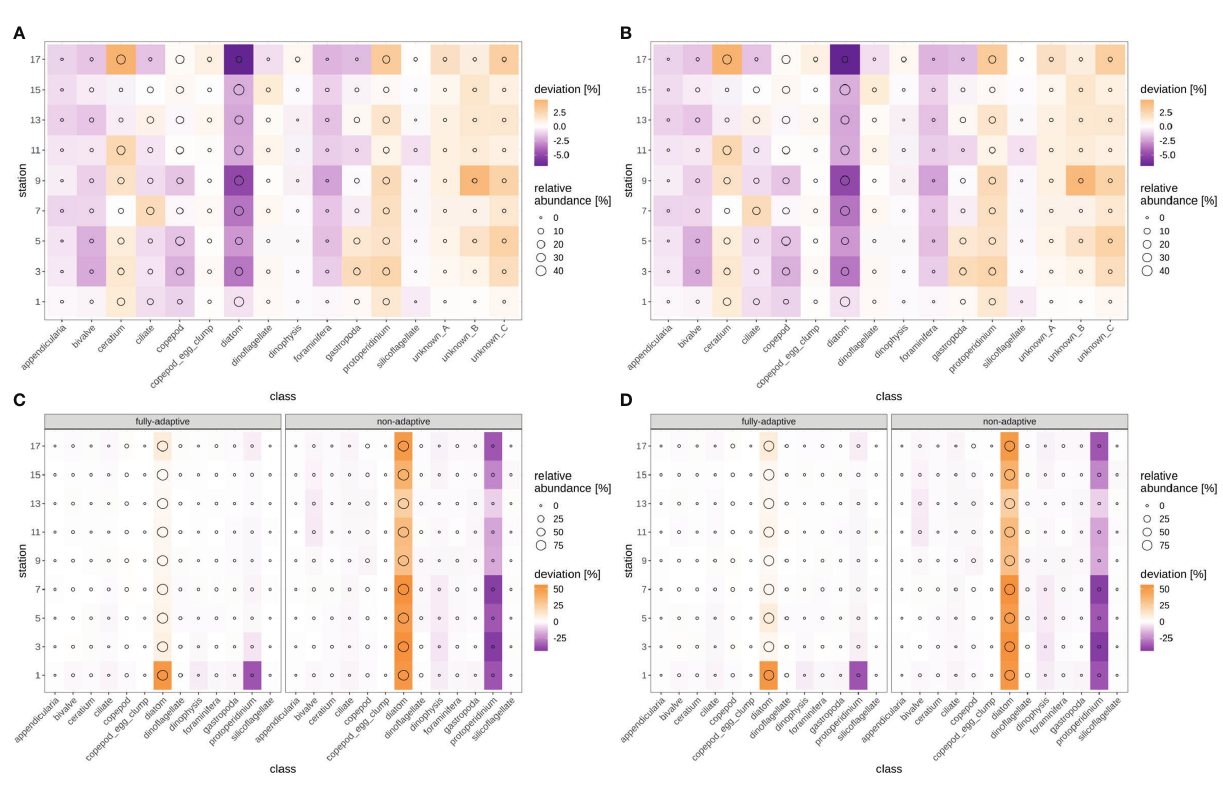
FIGURE 10 | Deviation between true and predicted (via non-validated automatic classi fi cation) relative class abundances, for the fully-adaptive DOC implementation and for classi fi cation of all samples with the baseline model (no adaptation). Circle size indicates true relative abundance. (A) : September survey, fi rst replicate, (B) September survey, second replicate; (C) : December survey, fi rst replicate, (D) : December survey, second replicate. Replicates differ in the random selection of images for training-set updates and random parameter initializations of models before training (see Case Studies – North Sea Surveys